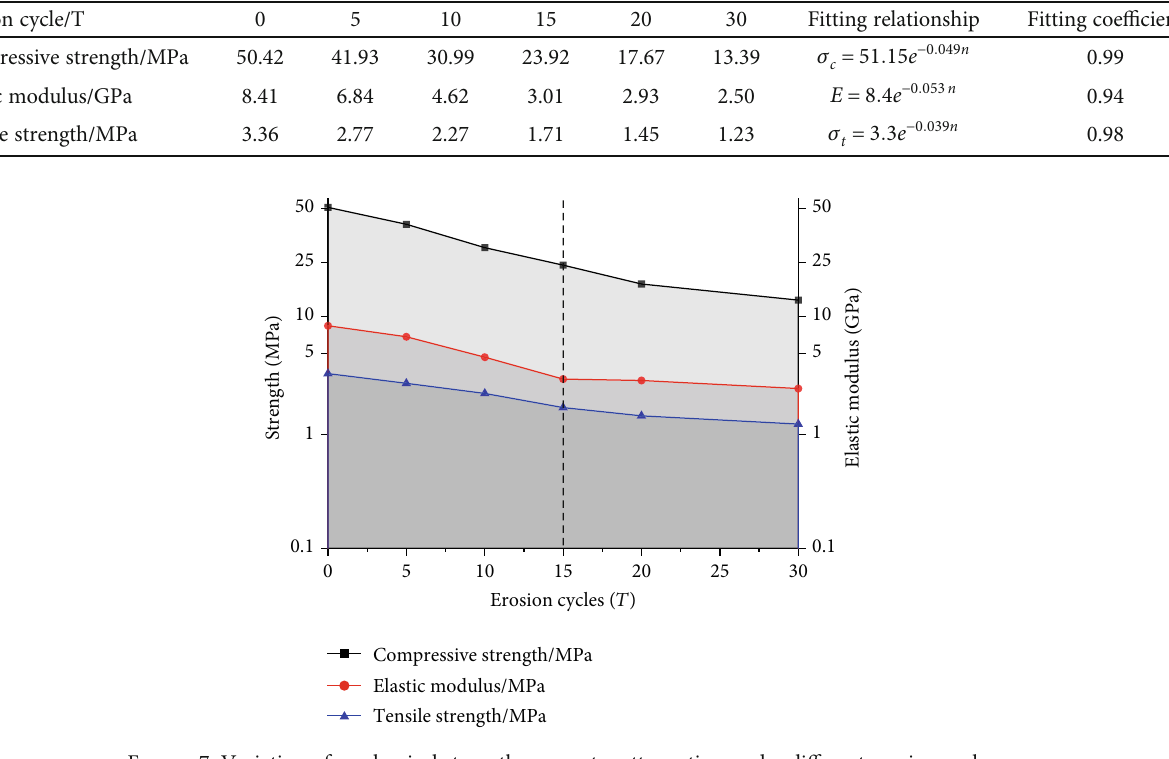
Figure 7: Variation of mechanical strength parameter attenuation under di ff erent erosion cycles. Table 3: Numerical simulation meso-parameter table. Erosion cycle/T